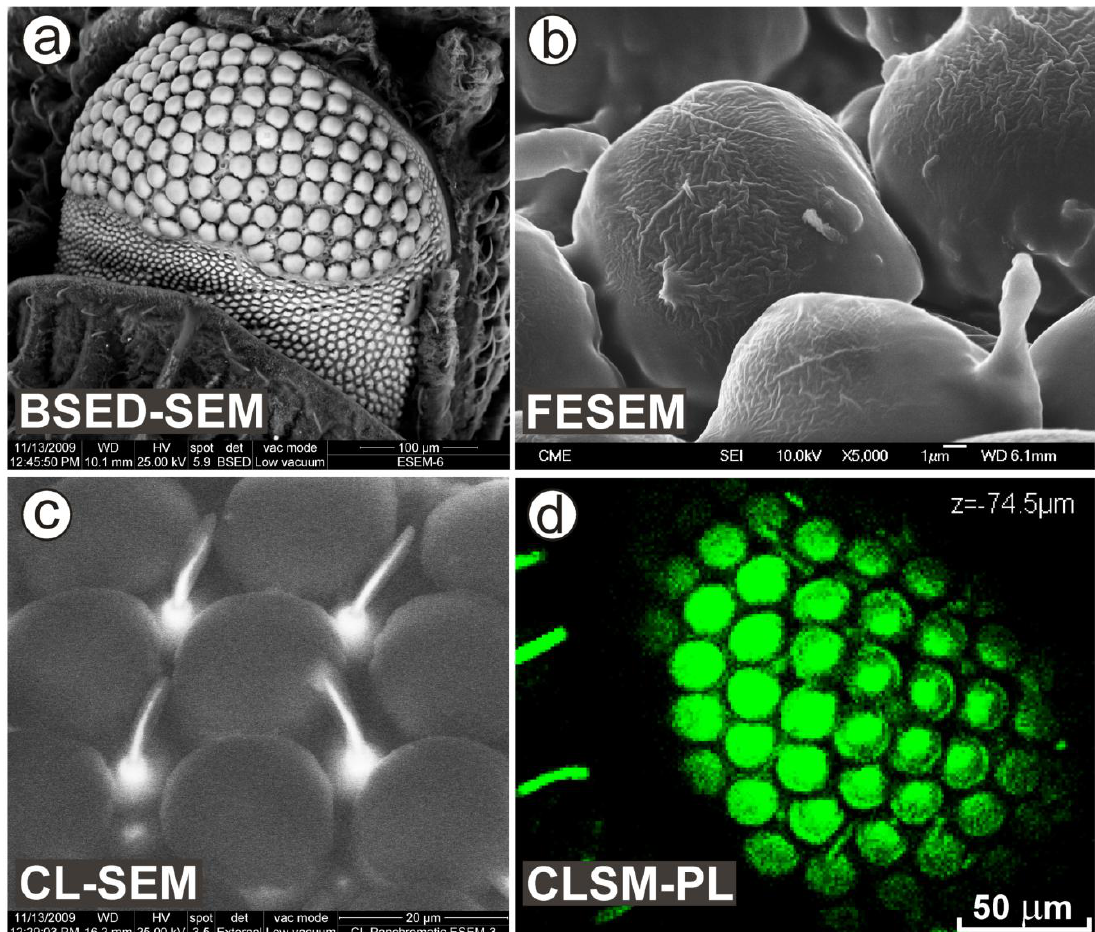
FIGURE 5. (a) Backscattering image under SEM of the calcium-phosphate mineralized eye showing some setae among the Copium . (b) FESEM image detailing the squeezed external proteinaceous-collagen membrane by dehydration. (c) CL panchromatic image under ESEM showing the most intense CL emission from setae in comparison with the surrounding ommatidia. (d) Photoluminescence image recorded in the CLSM, depicting both the mineralized areas as core crystal aggregates and on the internal ommatidium membrane